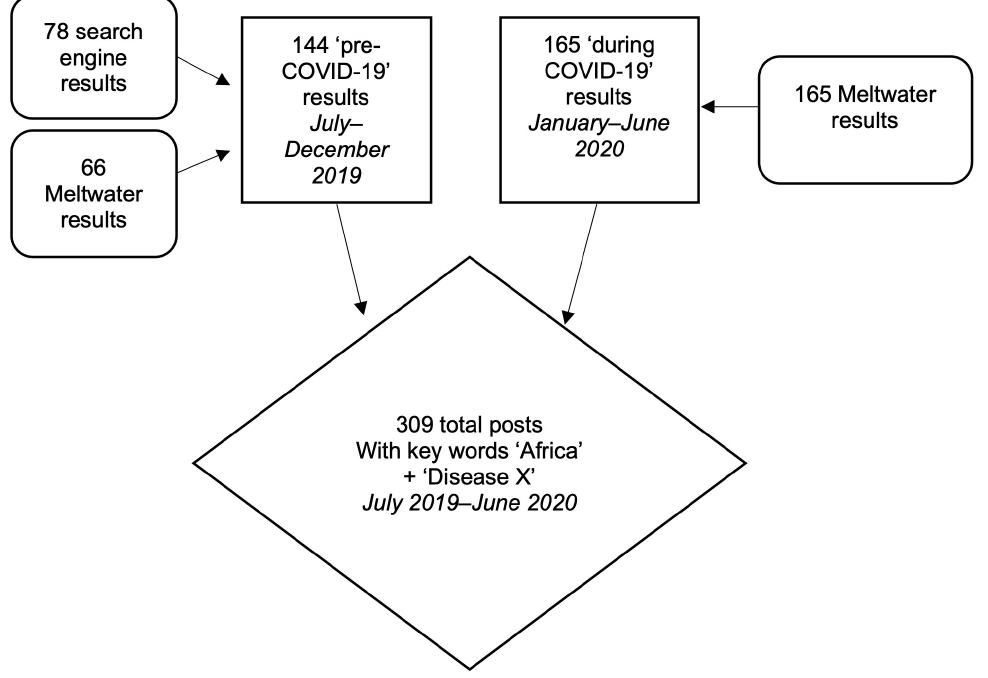
Figure 1 . Data collection process. Image by the